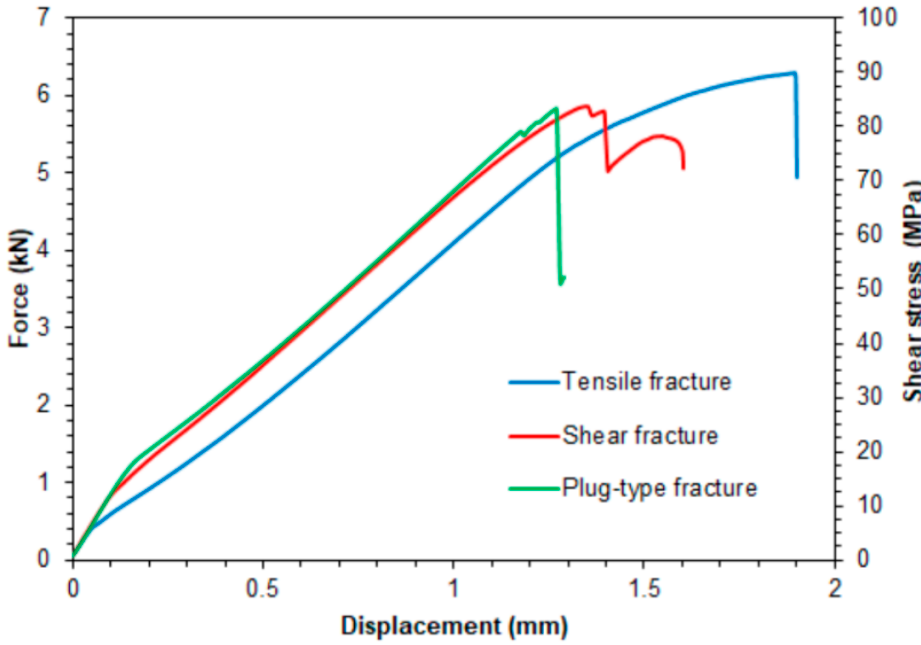
Figure 9. Force-displacement curves corresponding to specific fracture modes.